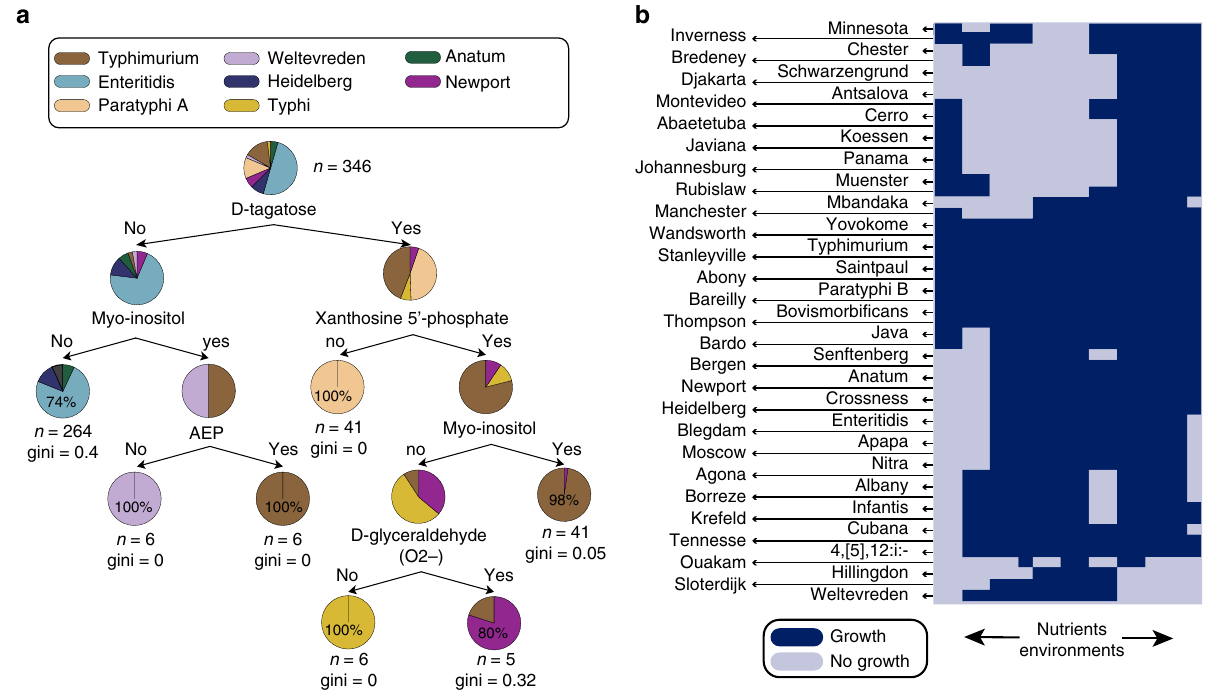
Fig. 3 GEM-predicted catabolic capabilities across 53 non-host-speci fi c serovars. a Eight serovars of S. enterica subsp . enterica can be classi fi ed based on their ability to catabolize six nutrients: D -tagatose, Xanthosine 5 ′ -phosphate, Myo -inositol, D -glyceraldehyde (anaerobically) and Aminoethylphosphonate (AEP). For purposes of clarity, serovars were included in this classi fi cation when there were more than 5 strains in the dataset that represented it. The ability to catabolize a given nutrient always leads to the right while the inability to catabolize the listed nutrient leads to the left. Note that glycolate utilization was removed from the features used to build the decision tree (see Supplementary File 1). b The catabolic capabilities of the 410 GEMs across 323 nutrient sources in 532 media conditions were computed. Here the catabolic capabilities for 53 generalists across 19 simulated nutrient environments are shown (see Supplementary Fig. 4 for a detailed list). Each strain is randomly chosen as a representative of a serovar. Growth of a particular strain in a particular medium condition (represented by a dark blue color) demonstrates a positive GEM predicted nutrient utilization capability. The full dataset for catabolic capability predictions across all strains is found in Supplementary Data 4. Serovar names are listed along with an arrow pointing to the row it corresponds to in the cluster